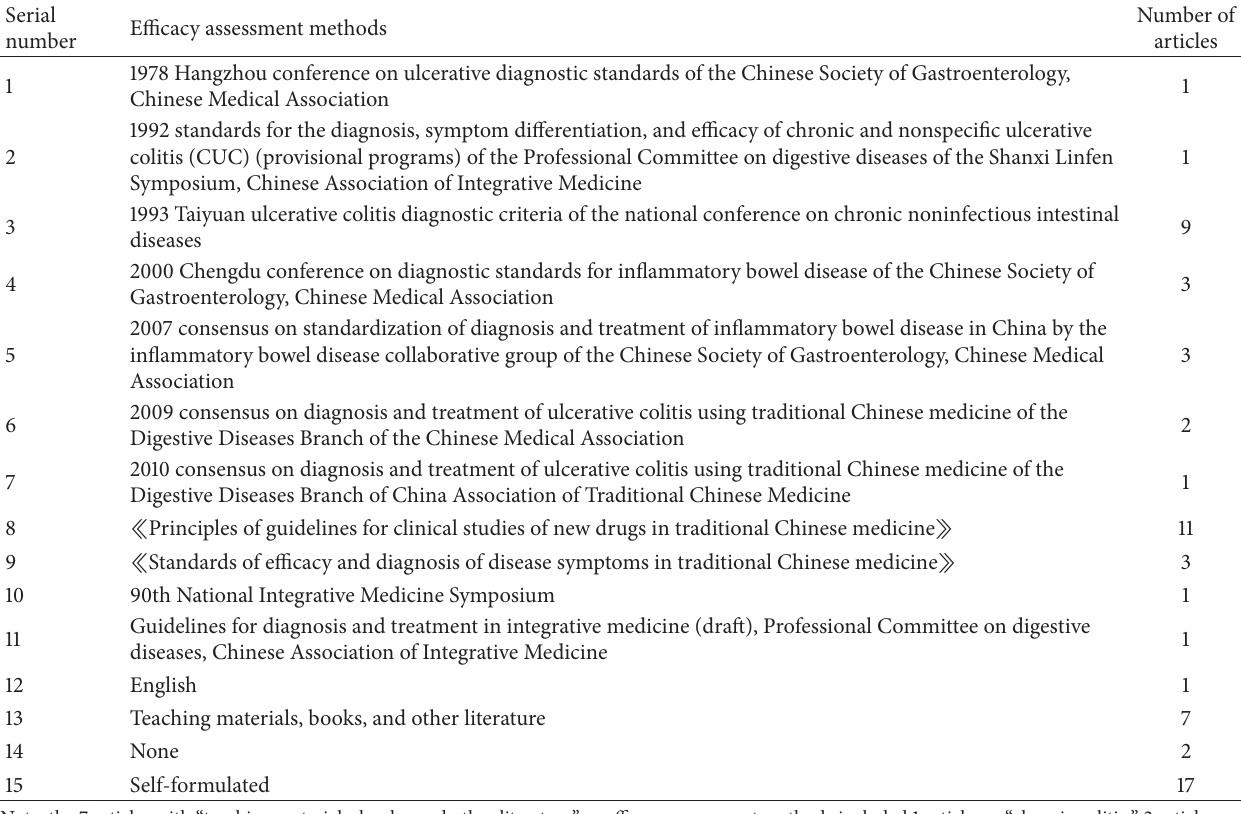
Table 8: Utilization of efficacy assessment